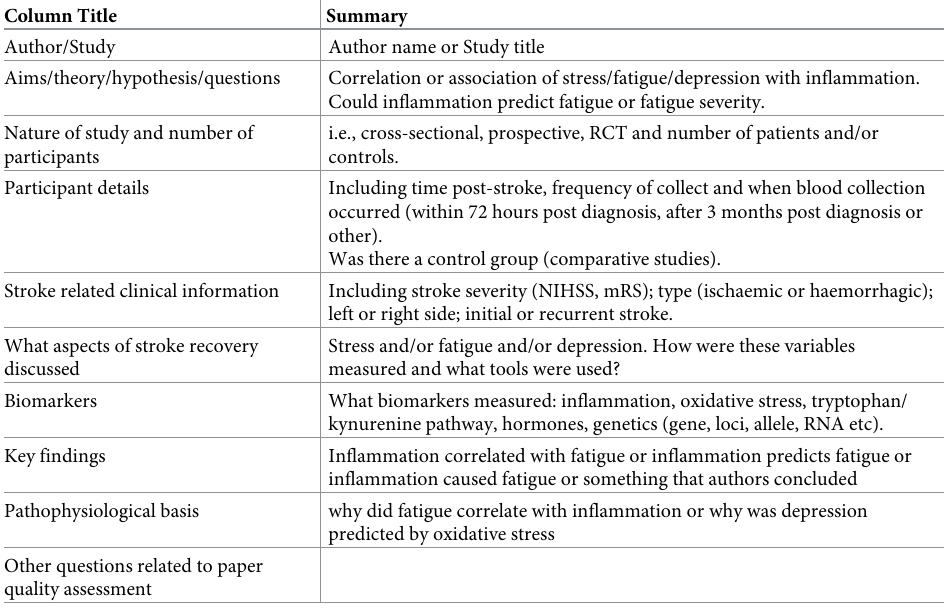
Table 3. Data extraction table